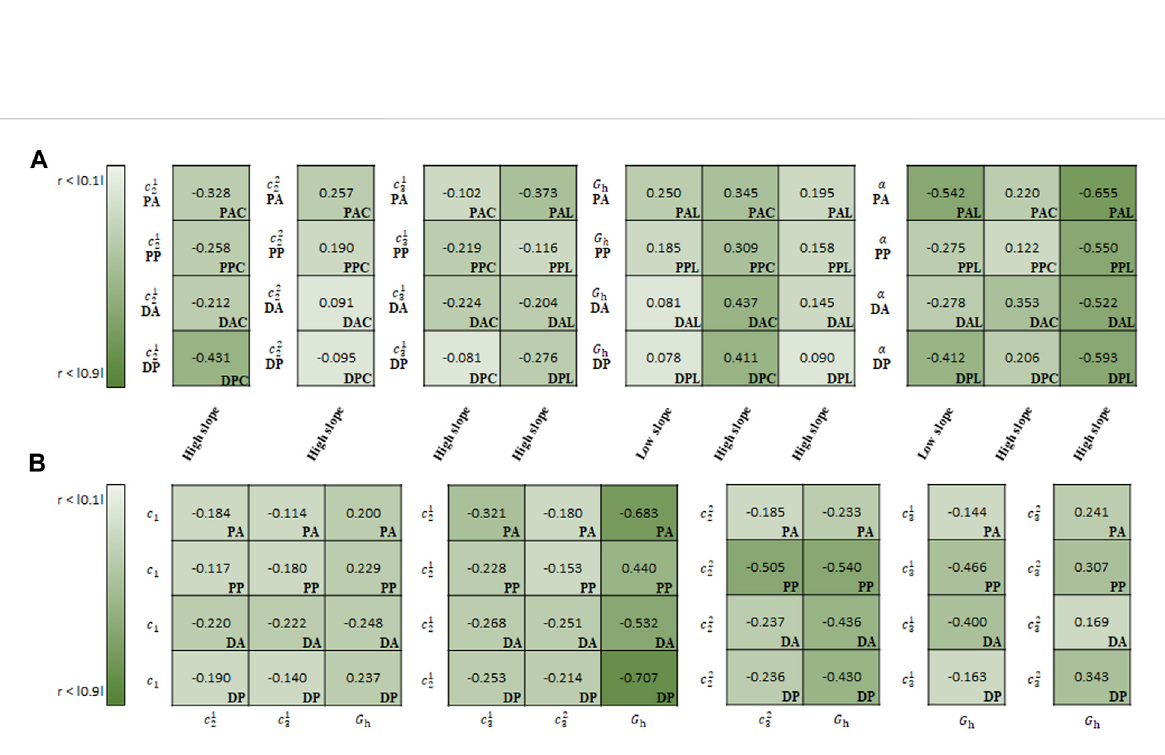
Frontiers in Bioengineering and